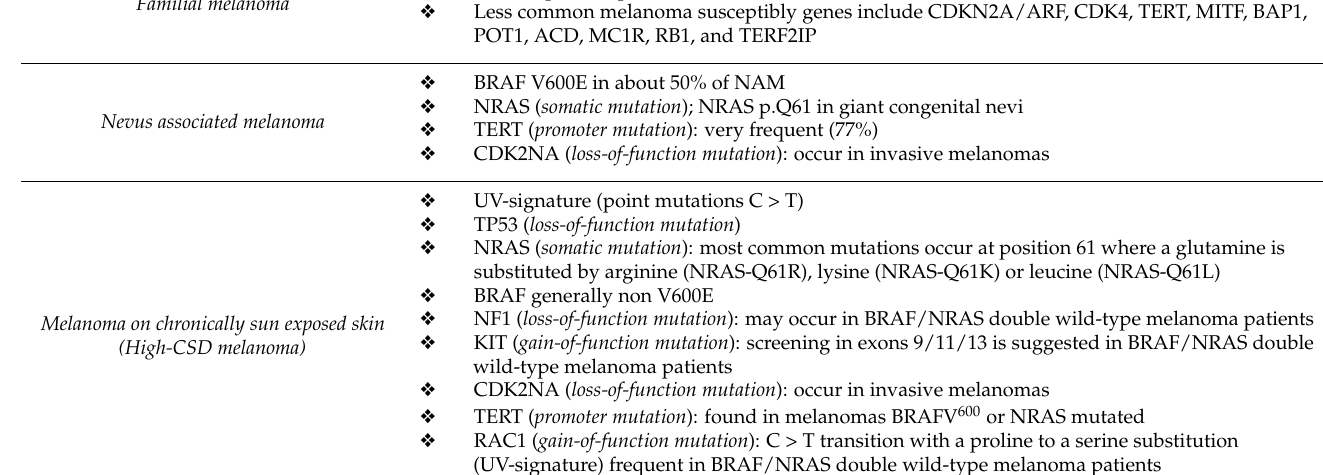
Table legend: C: cytosine. T: thymidine. CSD: cumulative sun damage. The TERT (Telomerase Reverse Transcriptase) gene on chromosome 5p15.33